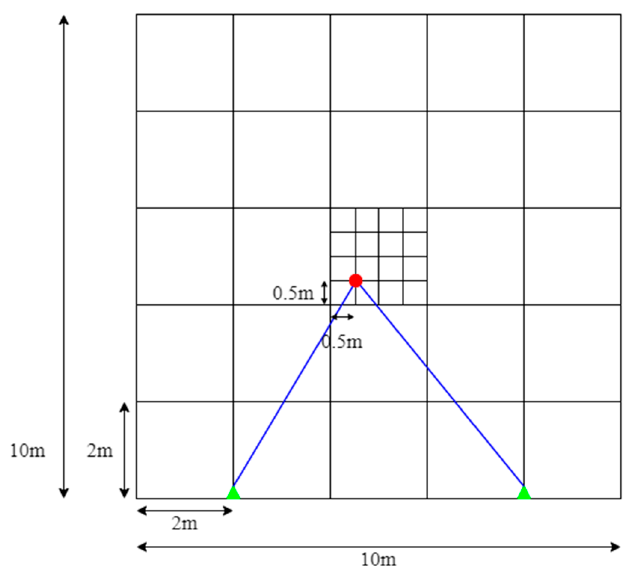
Figure 6. Label Find through DNN.